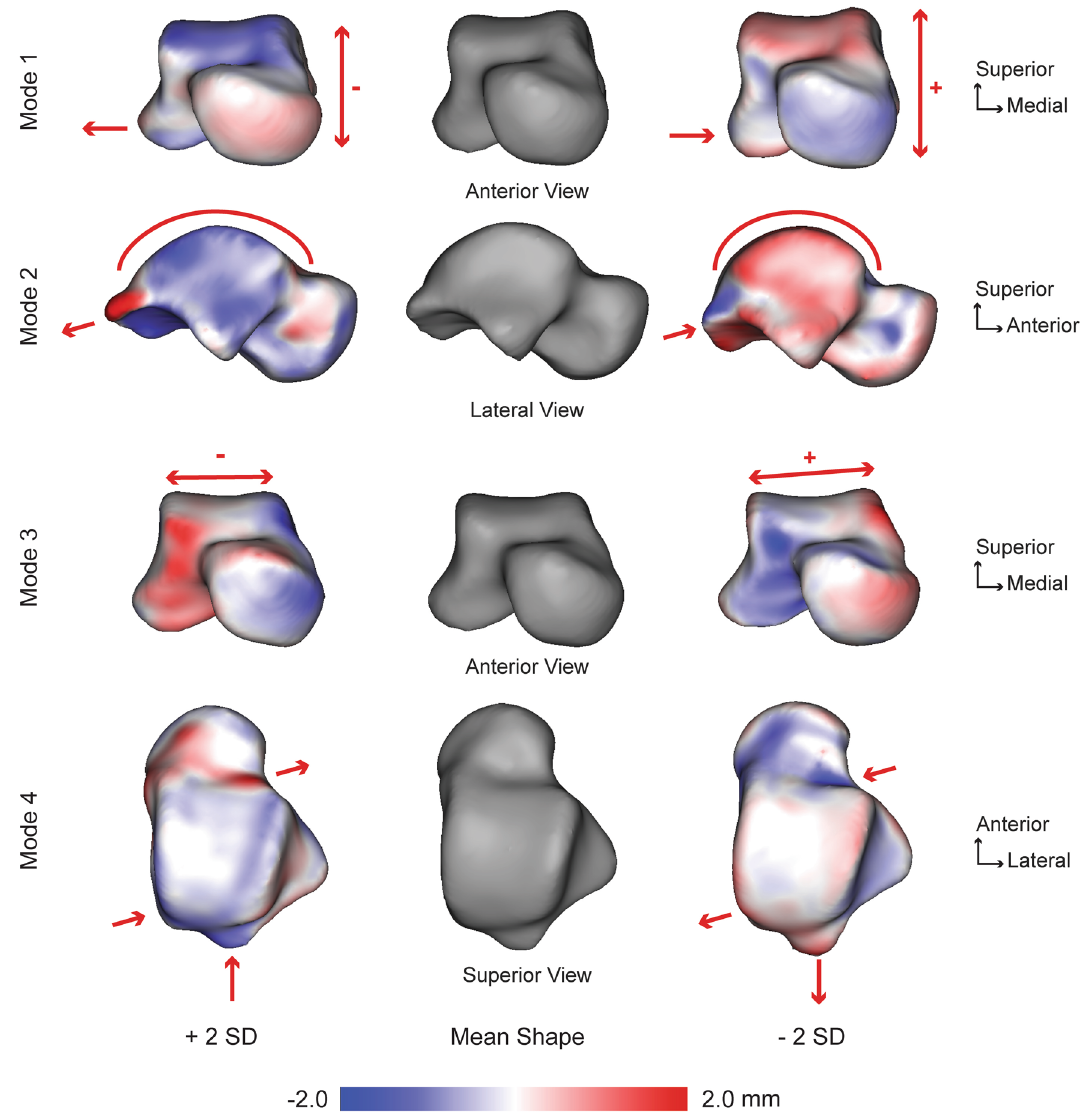
Figure 3. Talar modes of variation 1–4 showing significant anatomical differences observed at ± 2 standard deviations (SD) from the mean shape (center; grey). Red arrows focus on the location and direction of change for key anatomical features (pointing at the bone indicates the decreased size of a feature, whereas an arrow pointing away from the bone indicates an increased size of a feature). Surface distances shown on ± 2 SD represent the distance away from the mean shape with a scale in millimeters